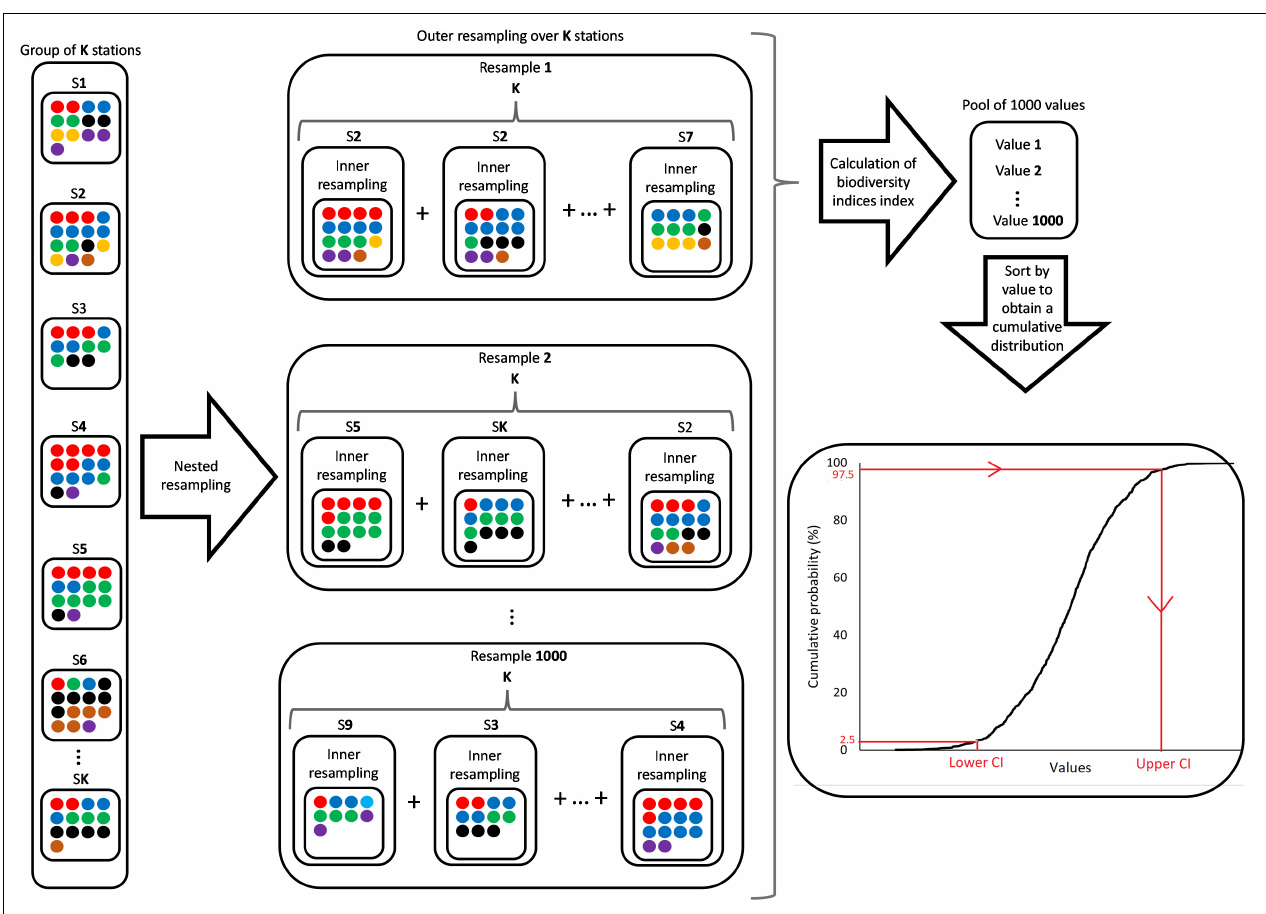
FIGURE 1 | Conceptual diagram on the methodological details of the nested bootstrapping approach applied to estimate uncertainties for the biodiversity indices. Stations S1 to SK have different number of species and number of individuals within each which is represented by colored circles where specific colors represent specific species. The nested bootstrapping consists of an outer resampling loop where the K stations are resampled. The data for each station selected in the outer loop is then resampled in the inner loop. This leads to variation in the composition of numbers of individuals for the same station depictured by the color mixtures for the resampled station data. The inner resampled data belonging to the same outer resampling iteration are summed to produce a pooled population symbolized by the “+.” The obtained data from each pooled population are then used separately to calculate a value for each of the biodiversity indices. Lower and upper confidence limits for each diversity index is subsequently obtained from the cumulative distribution of values. Specifically, the value for the index that corresponds to the 2.5 and 97.5 percentiles represents respectively, lower and upper confidence limits, and thereby forms a 95% percentile confidence interval for the specific